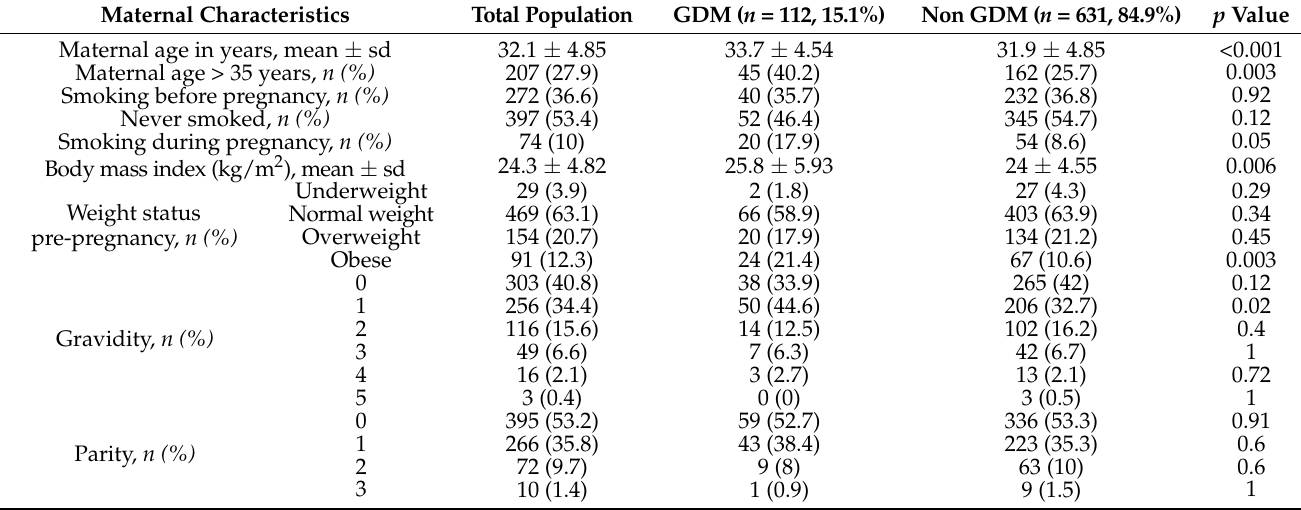
Table 1. Characteristics of individuals with GDM and no